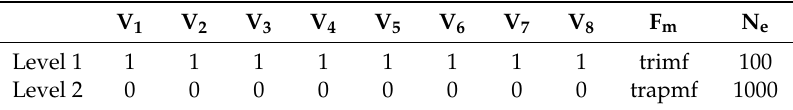
Table 1. Factors and factor levels for the